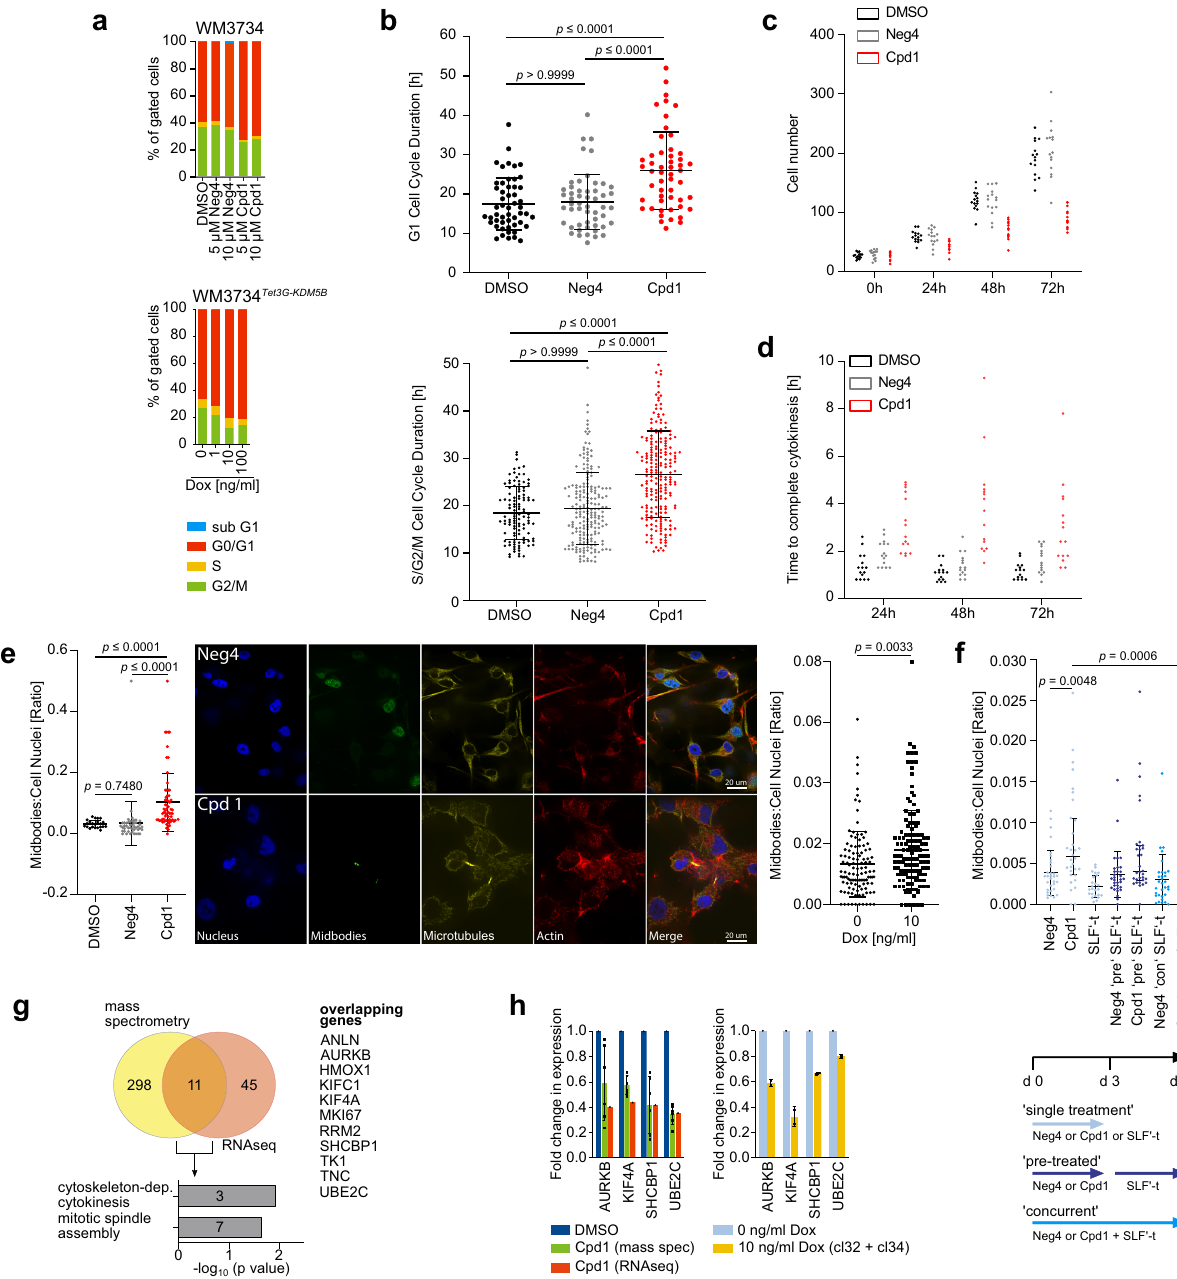
Fig. 3 KDM5B-mediated cell cycle arrest and inhibition of cytokinetic abscission. a Propidium iodide cell cycle analysis of Cpd1-treated WM3734 (above) or Dox-treated WM3734 Tet3G-KDM5B cells (below) after 72 h. Shown are representative data ( n = 4). b Quantitation of the G1 (upper panel) and S/ G2/M (lower panel) cell cycle duration by real-time cell cycle imaging of FUCCI-WM164 cells pretreated with Cpd1 (10 µ M) vs. DMSO or Neg4 controls (10 µ M) for 72 h. Scatter dot plots represent mean ± SD ( n = 3); Kruskal – Wallis test. c Time-lapse imaging analysis of WM3734 cell numbers during treatment with Cpd1 (10 µ M) vs. DMSO or Neg4 controls (10 µ M) up to 72 h (15 different areas, n = 2). d Time-lapse microscopic movies were analyzed for the time to complete cytokinesis (15 different cells, n = 2). e Quantitation and representative immuno fl uorescence staining of midbodies in Cpd1- treated (72 h) WM164 cells (left) and Dox-treated WM3734 Tet3G-KDM5B cells (right) vs. respective controls. Depicted are single fl uorescence channels: blue (DAPI, nucleus); yellow ( α -tubulin, microtubules); green (Aurora B kinase, midbodies); red (phalloidin, F-actin). Dot plots show the ratio of midbodies/cell per fi eld of view, 12 – 16 fi elds, n = 3. Mean ± SD, left, one-way ANOVA: right, two-sided t -test. f Quantitation of midbody decrease in the KDM5B-PROTAC model. Proteasomal degradation of KDM5B was induced by SLF ′ -thalidomide (SLF ′ -t) concurrently applied with Cpd1 ( “ con ” ) or applied after Cpd1 pre-treatment for 3 days ( “ pre ” ). Neg4 was used as control. Dot plots show the ratio of midbodies/cell nuclei as median values with the interquartile range (4 coverslips, n = 2; one-way ANOVA). g Venn diagram and gene ontology analysis of signi fi cantly regulated genes upon Cpd1 (10 µ M) treatment of WM3734 cells as detected by mass spectrometry and RNA sequencing. h Quantitation of downregulation of selected cytokinesis regulators as assessed by mass spectrometry and RNAseq (left, n = 1) or qPCR (right, mean ± SD, n = 2) in Cpd1-treated WM3734 and Dox-treated WM3734 Tet3G-KDM5B cells. Source data are provided as a Source Data fi le.